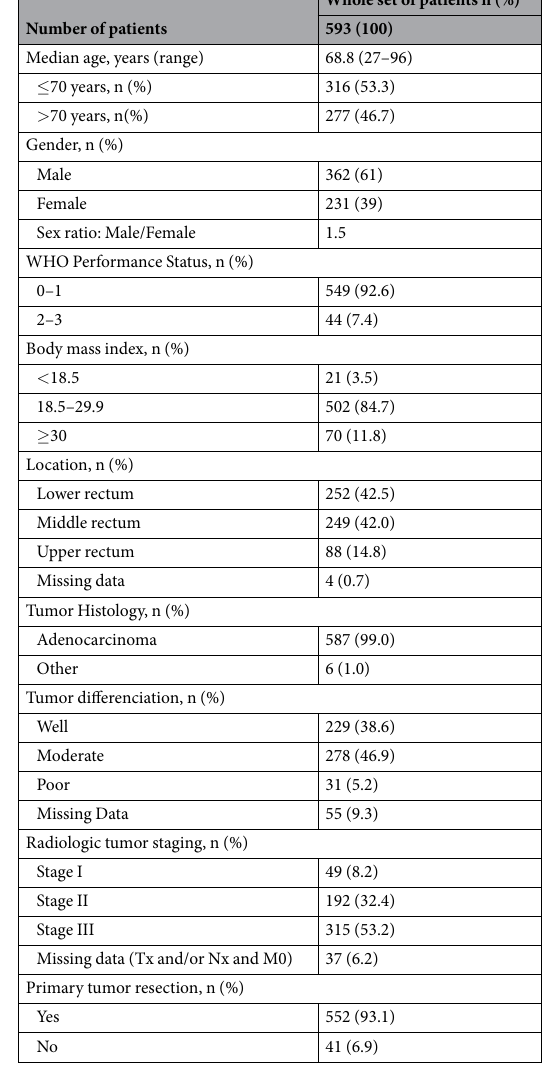
Table 1. Patient and tumor characteristics. Q1: first quartile, Q3: third quartile, n: number of patients, Tx: unknown tumor staging, Nx: unknown node involvement staging, Tumor staging was based on